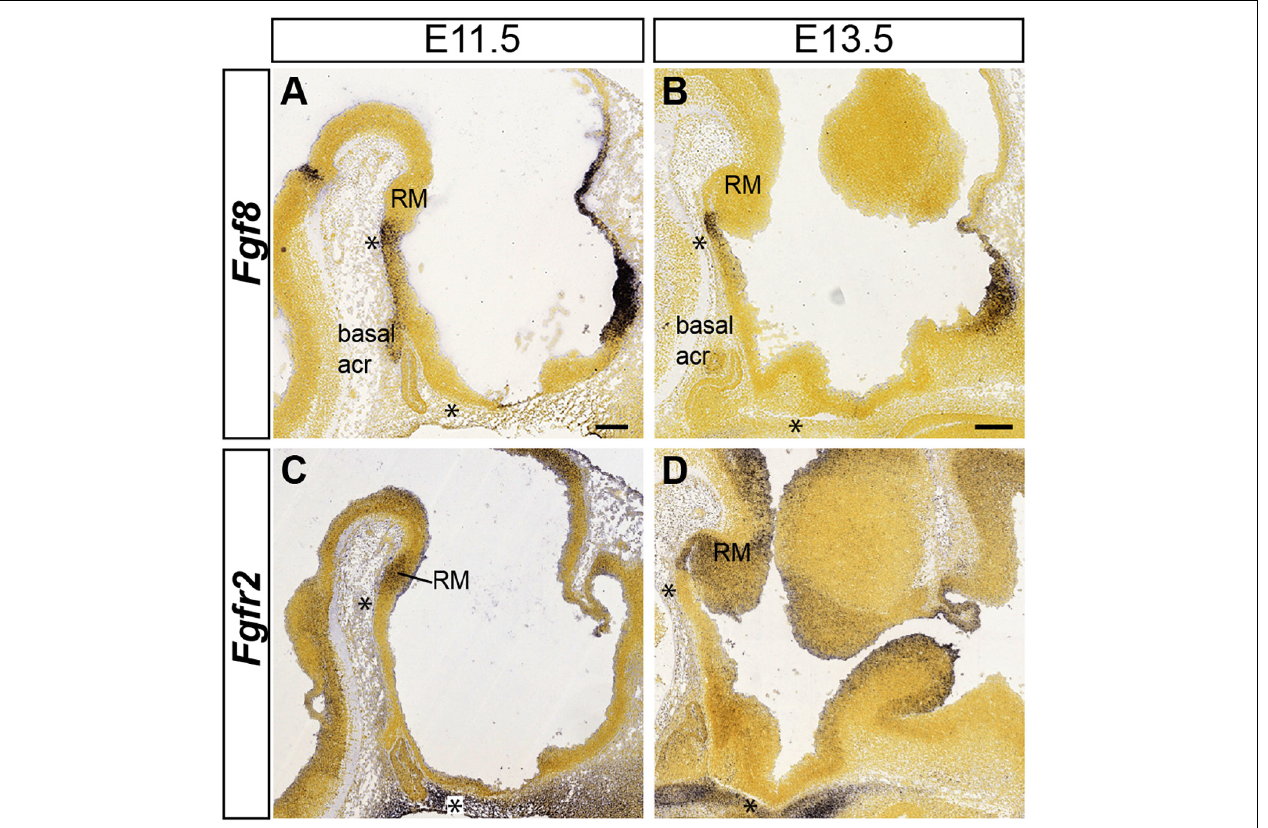
FIGURE 12 | Mamillary acroterminal expression of Fgf8 and RM signal of its receptor Fgfr2 at early stages. Allen Developing Mouse Brain Atlas images are shown to illustrate the close location of an acroterminal FGF8 source to one of its possible receptors at the RM. (A) Fgf8 is active at the mamillary part of the acroterminal basal plate at E11.5. (B) At E13.5 Fgf8 expression becomes restricted at the ventralmost mamillary acroterminal domain (see asterisks in A , B ). (C,D) The diffusible FGF8 protein (out of the asterisk-marked acroterminal domain) can activate transcripts of the Fgfr2 receptor produced in the hypothalamic basal plate, including RM at both E11.5 and E13.5. Scale bar in (A) represents 200 µ m and is valid for (C) . Scale bar in (B) represents 200 µ m and is valid for (D)